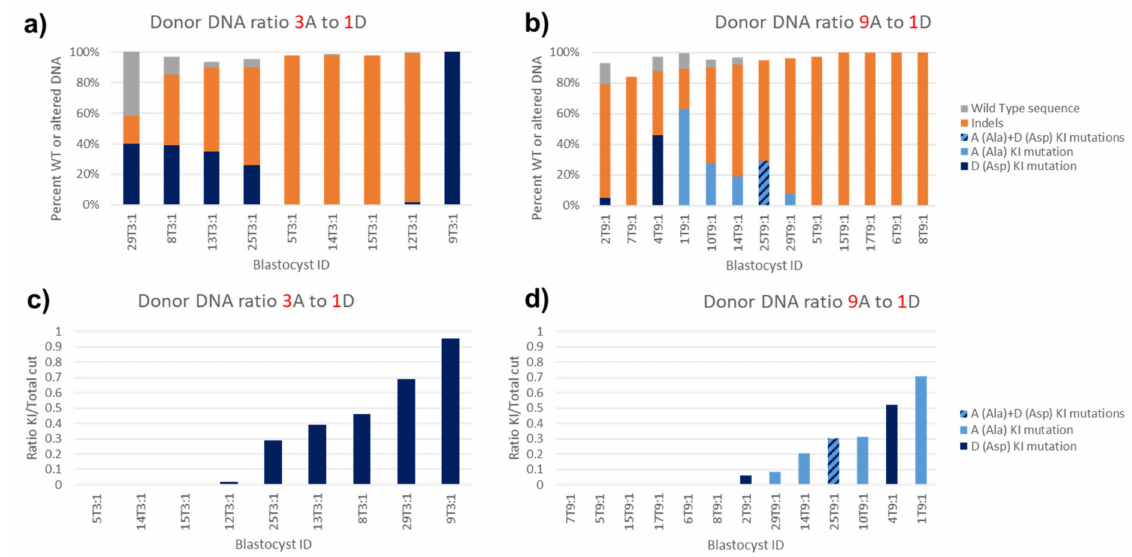
Figure 6. Sequence incorporation by two DNA donors (one for S202A and one for S202D) injected simultaneously. Simultaneous incorporation of two di ff erent KI sequences into the same genomic DNA position occurred when, along with Cas9 and a single guide RNA, zygotes were injected with a mixture of two donors. One donor had the sequence to convert mouse Terf2ip serine 202 into alanine (A) and the other, into aspartic acid (D). ( a , b ) The proportion of wild type, indel, A KI mutation and D KI mutation sequences were quantified and plotted. ( c , d ) The ratio of successful KI to total detected cut DNA was plotted. ( a , c ) A mixture of three times more donor DNAs directing for A than donor DNA directing for D was injected. Despite having 3 times more donor DNA available, no A KI mutations were seen, only D. ( b , d ) A mixture of nine times more donor DNAs directing for A than donor DNA directing for D was injected. Slightly more blastocysts incorporated the A donor sequence than did D. One blastocyst incorporated both the A and D donor sequences.